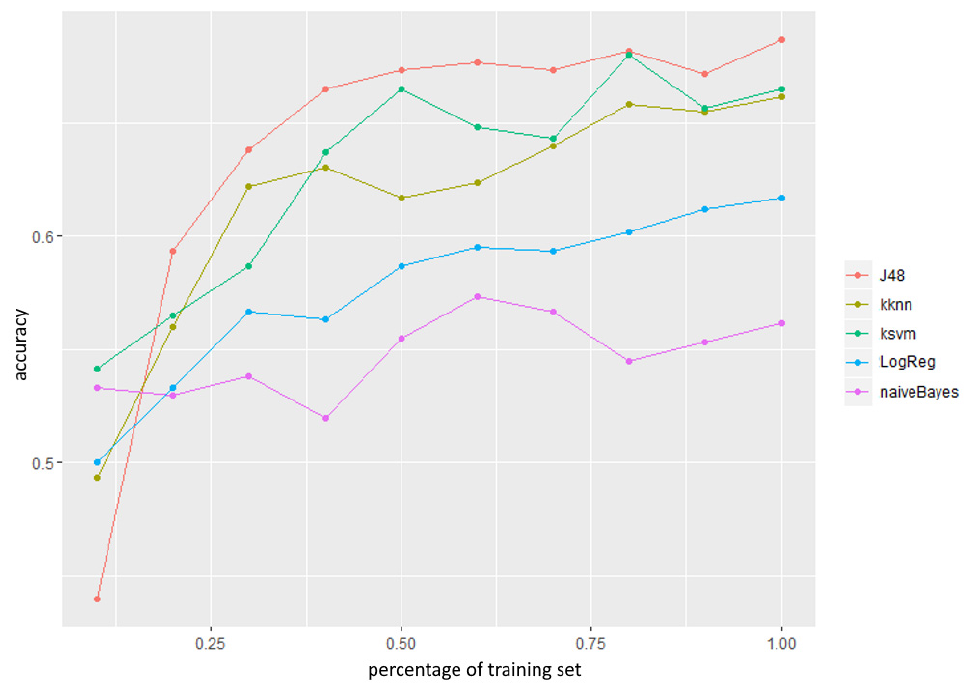
Figure 2. Learning curve used for classification